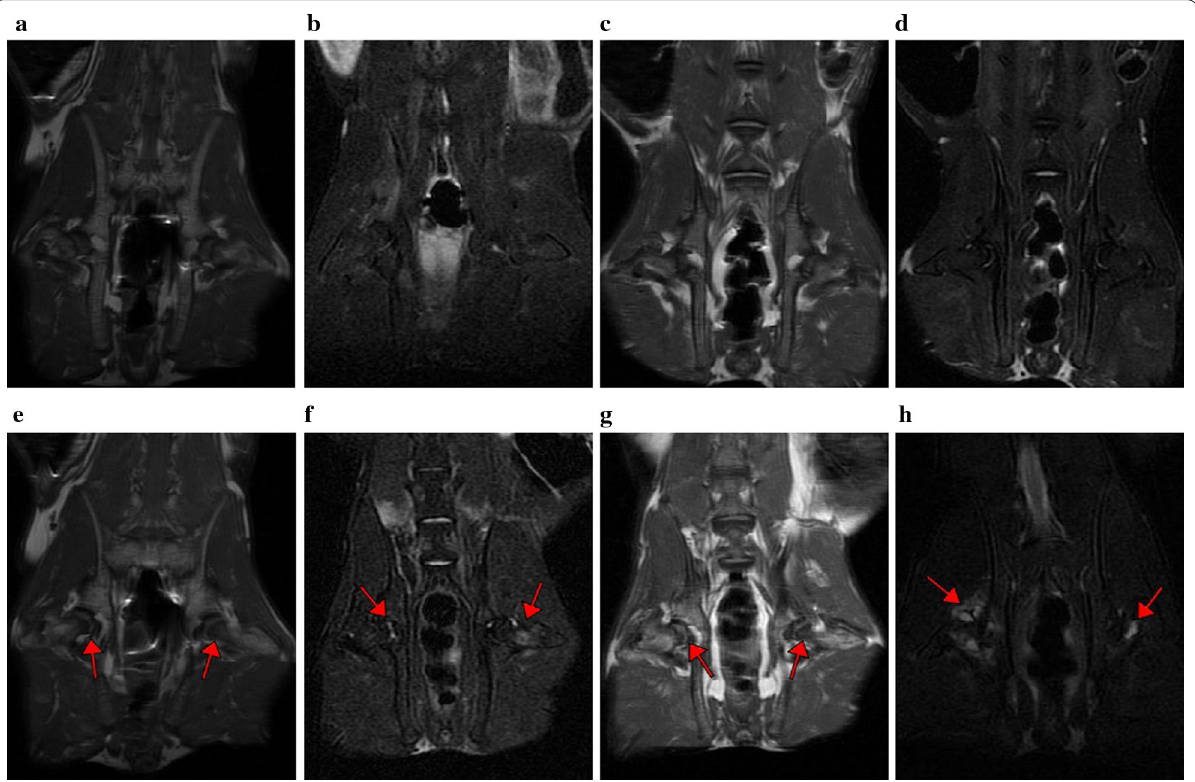
Fig. 1 MRI. a and b were T1WI and T2WI coronal image at 2nd week after injection of hormone in the model group; e and f were T1WI and T2WI after injection of hormone in the model group; g and h were T1WI and T2WI in the model group. (Red arrows indicated osteonecrosis low/high signal in T1WI and T2WI